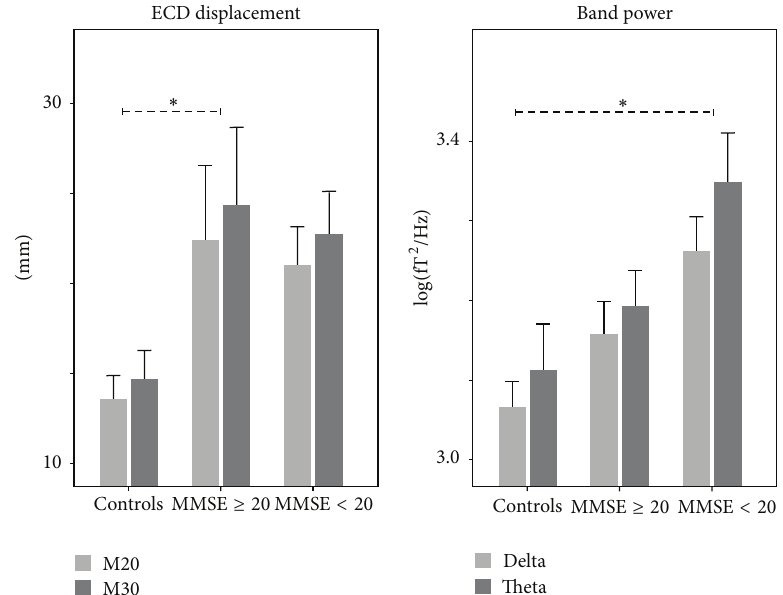
Figure 3: Patients’ clinical severity in relationship with left displacements and rest low band powers. Mean and standard errors in controls and patients are subdivided in moderate (MMSE 25–21) and severe (MMSE ≤ 20) clinical severity. Left : M20 and M30 ECD in the left hemisphere. Right : delta and theta bend powers of left and right activity in resting state.